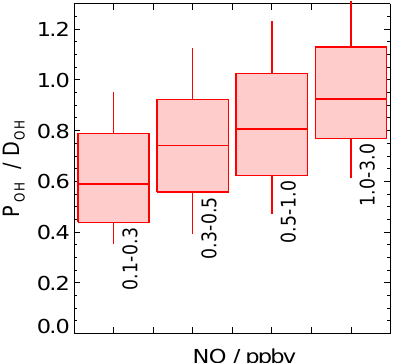
Figure 10. Box and whisker plot of the ratio of the total OH pro- duction ( P OH ) and the OH destruction rate ( D OH ) as a function of the NO mixing ratio for daytime values. Boxes give 25 and 75 percentiles, and whiskers give 10 and 90 percentiles. Data are only included if all required trace gas concentrations and OH reactivity were measured concurrently. Gray areas indicate